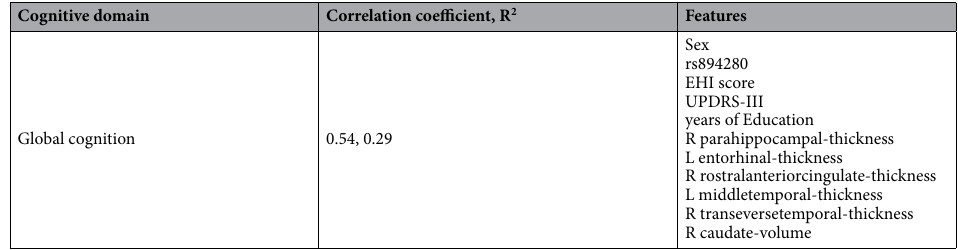
Demographic/clinical characteristics Mean, SD, (Min, Max)